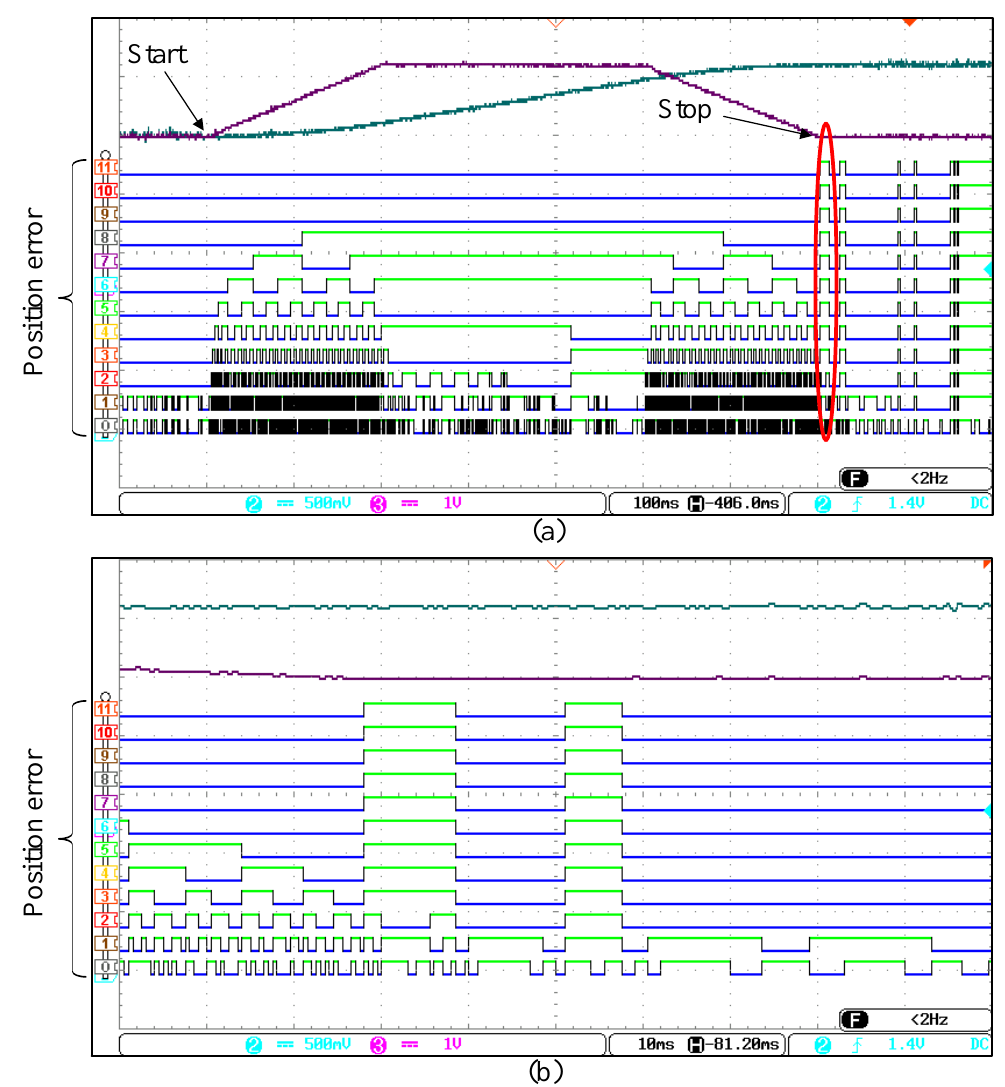
Figure 13. The experimental results with switching control. ( a ) The position, speed and position tracking error. ( b ) Zoom picture of ( a ).